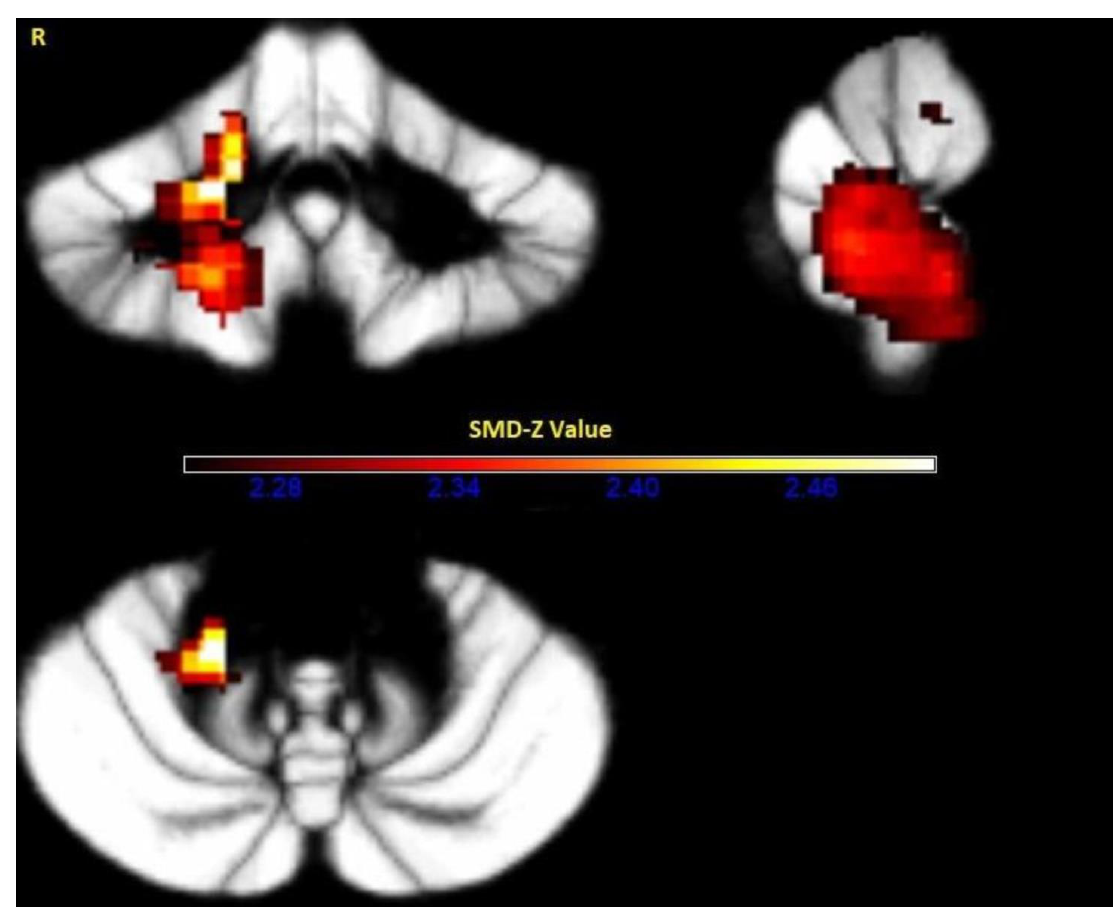
Figure 3. Gray matter decreased in the cerebellar vermis and the right cerebellar hemisphere of the essential tremor patients compared to normal controls. SDM=Seed-based d Mapping.